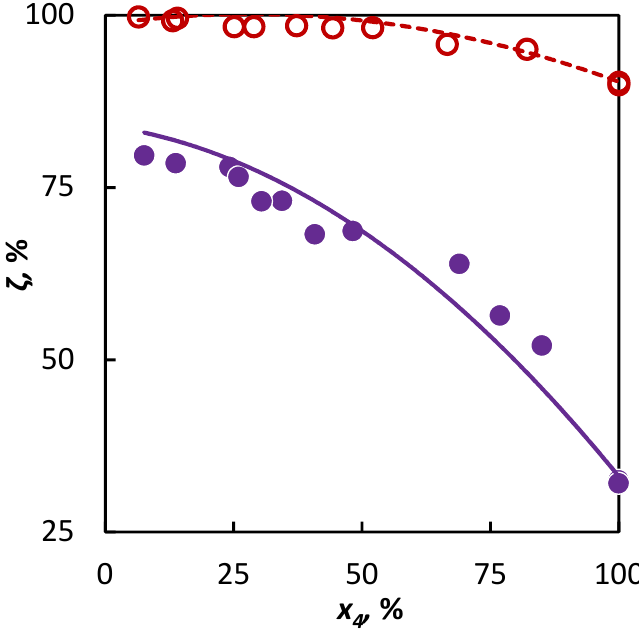
Figure 4. Co-pyrolysis of C4 hydrocarbons and heptane: conversion of C4 hydrocarbons ( ○ 2-butene and ● isobutene) in dependence on their mole fraction in the binary mixture. Points represent experimental data; solid line was obtained from regression analysis and dashed line is a simulation.